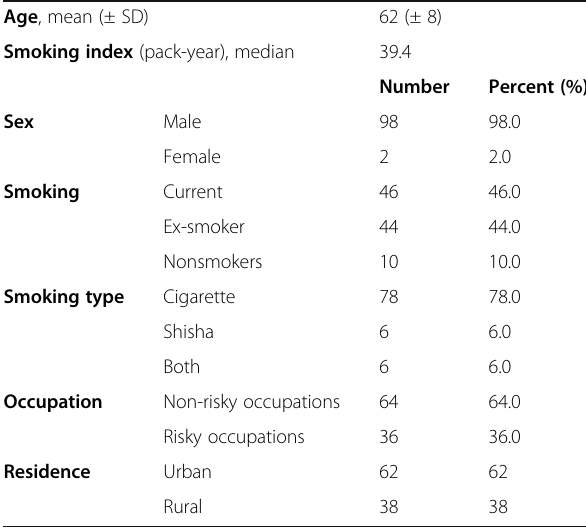
Table 3 Isolated bacteria from sputum of studied